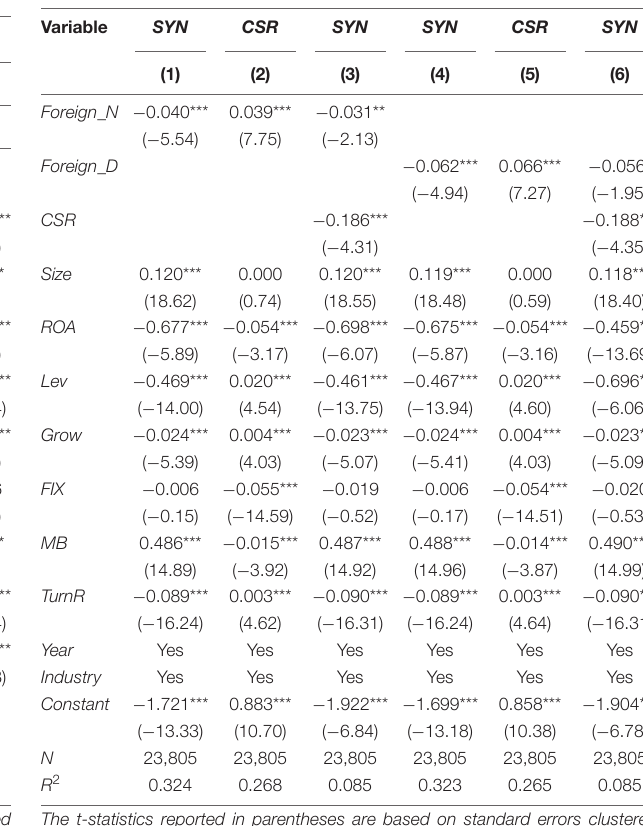
TABLE 5 | Mechanism